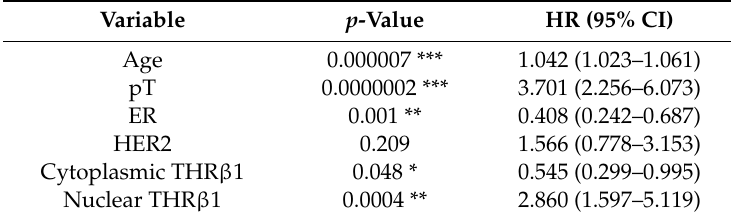
Table 5. Multivariate analysis (OS, overall survival) of clinicopathological variables and THR β 1.